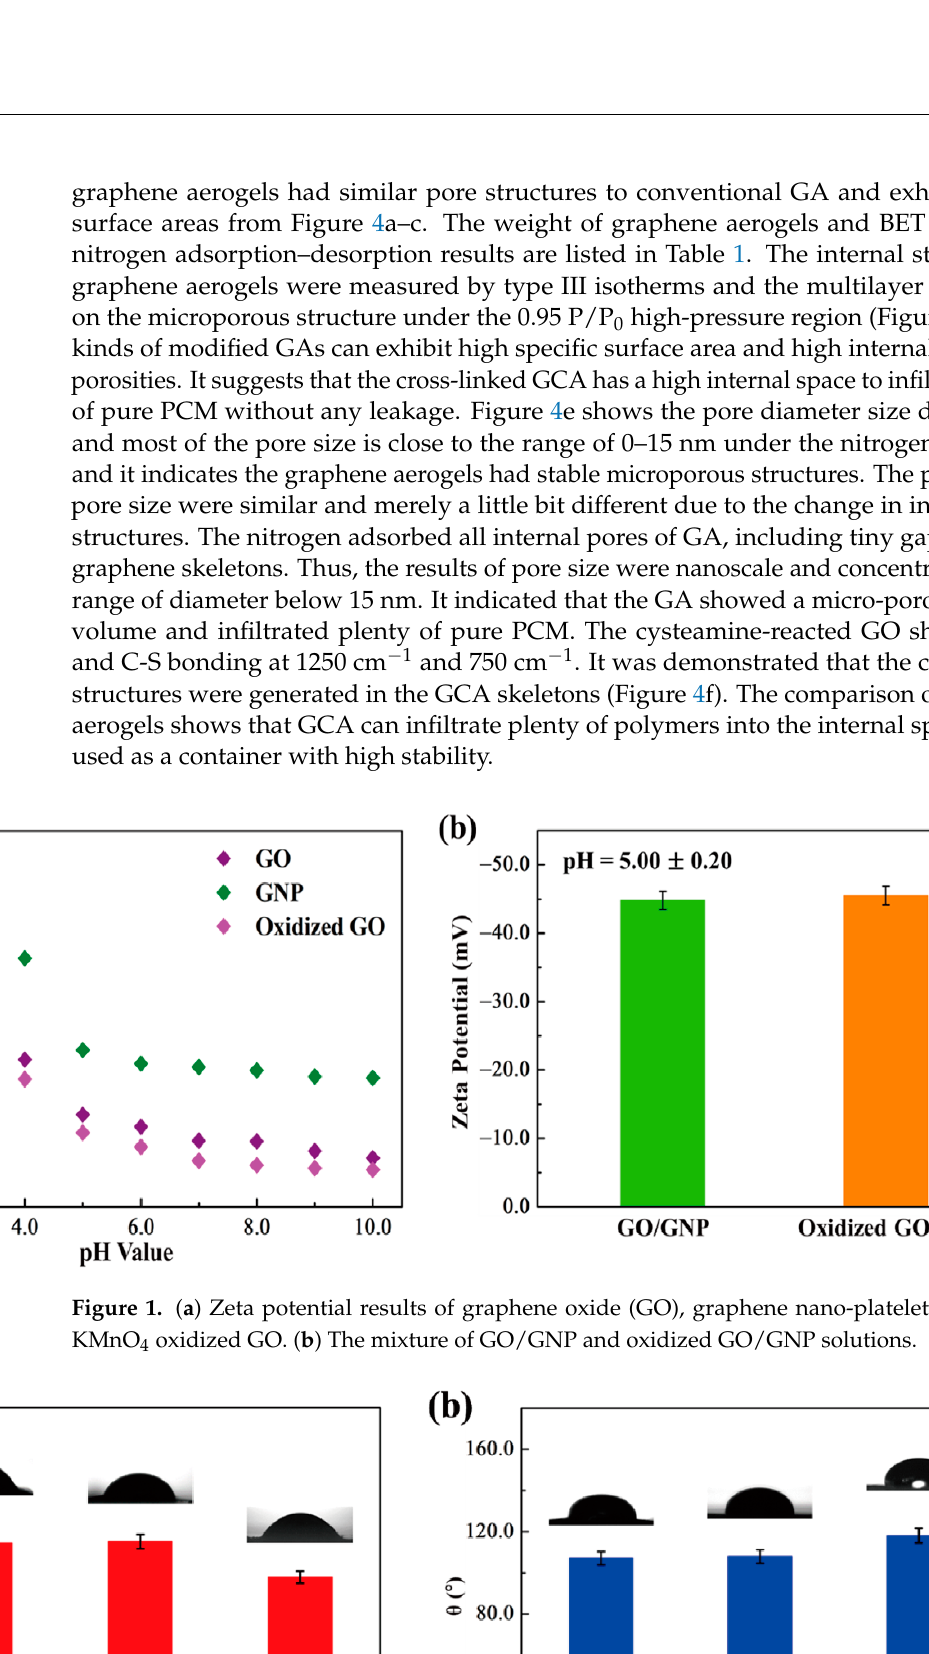
Figure 3. Photographic images of ( a ) graphene aerogel (GA), ( b ) GA/PDMS, and ( c ) GCA. ( d ) Stress– strain curves of the graphene aerogels.